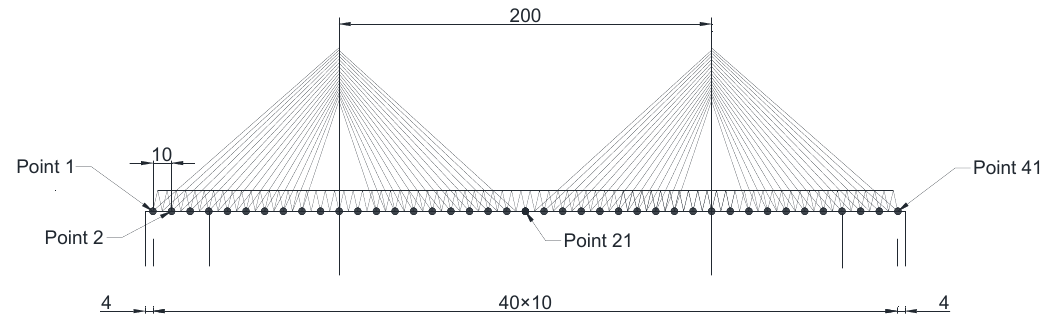
Figure 1. Simulation points distributed on bridge deck.